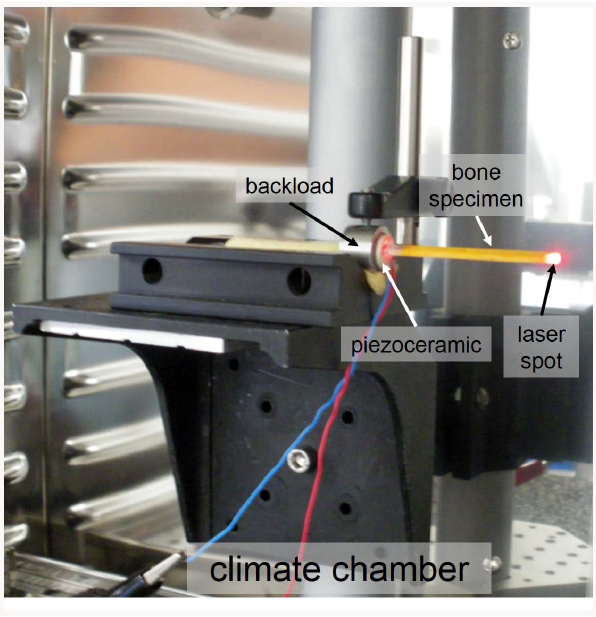
Figure 2. NRUS experimental setup. Bone specimen bonded on a piezoceramic emitter is placed in a climate chamber.